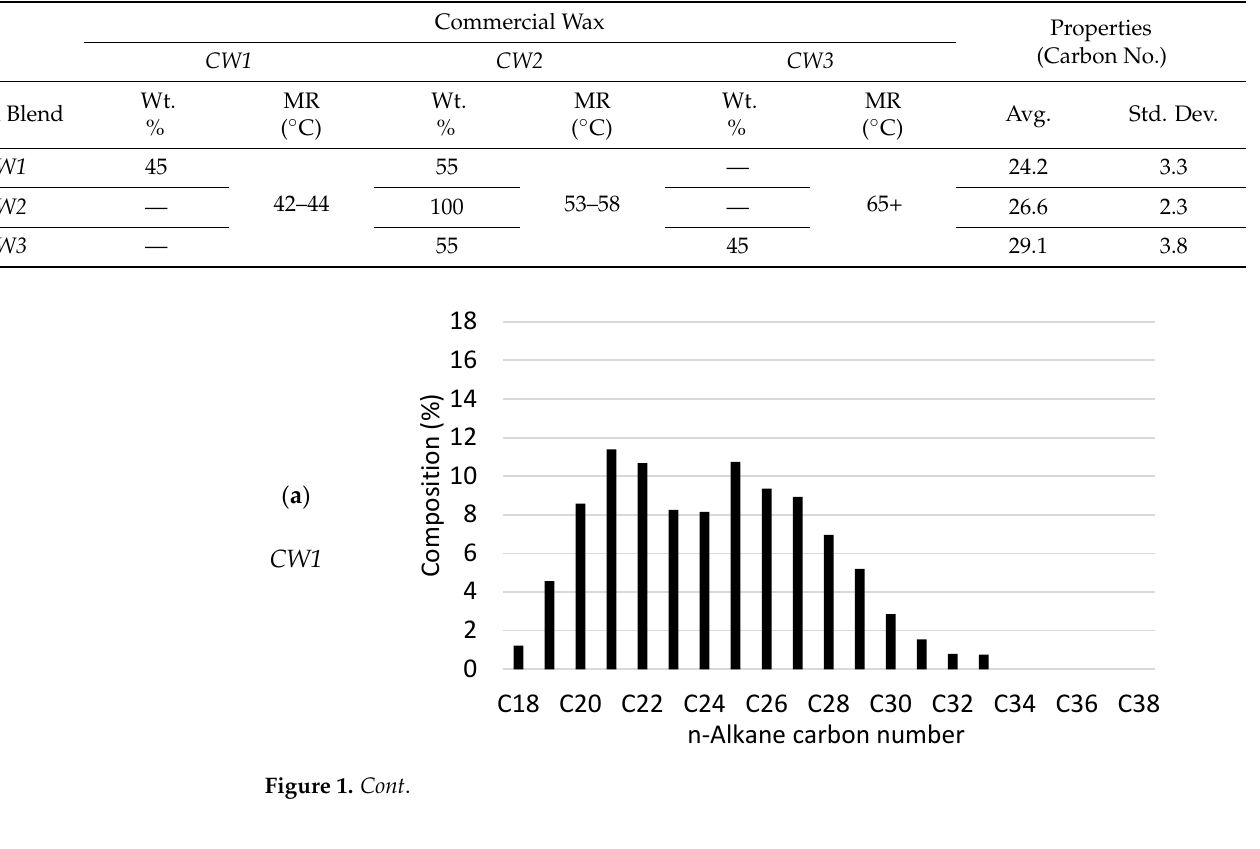
Table 1. Wax composition and melting ranges.